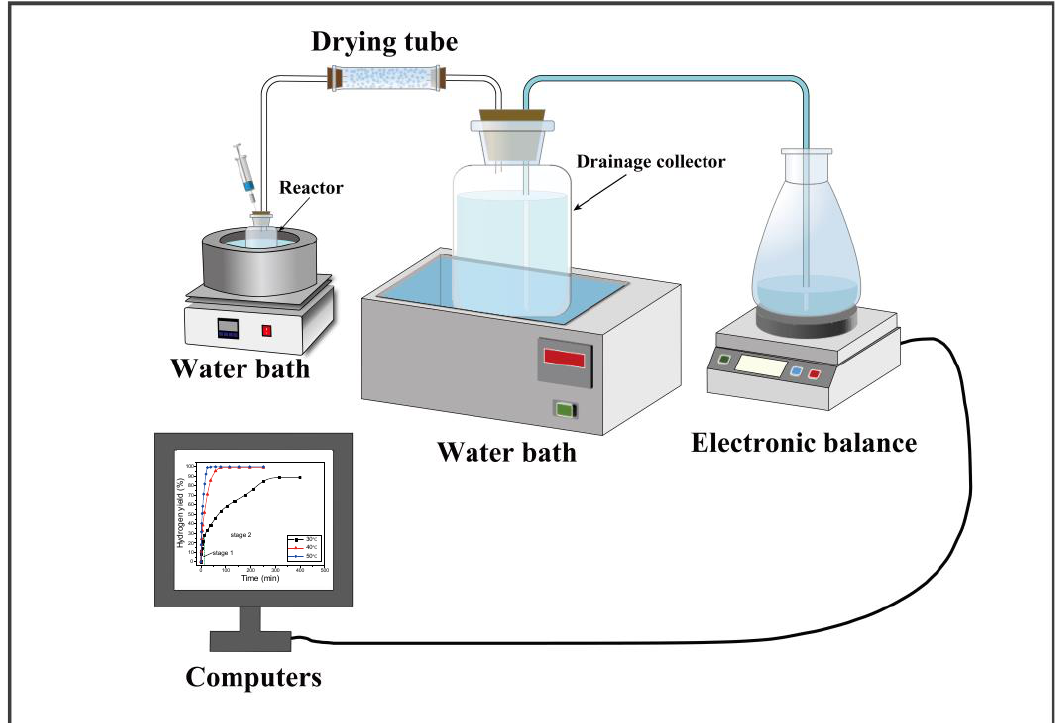
Figure 1. The experimental system used for measuring hydrogen production.